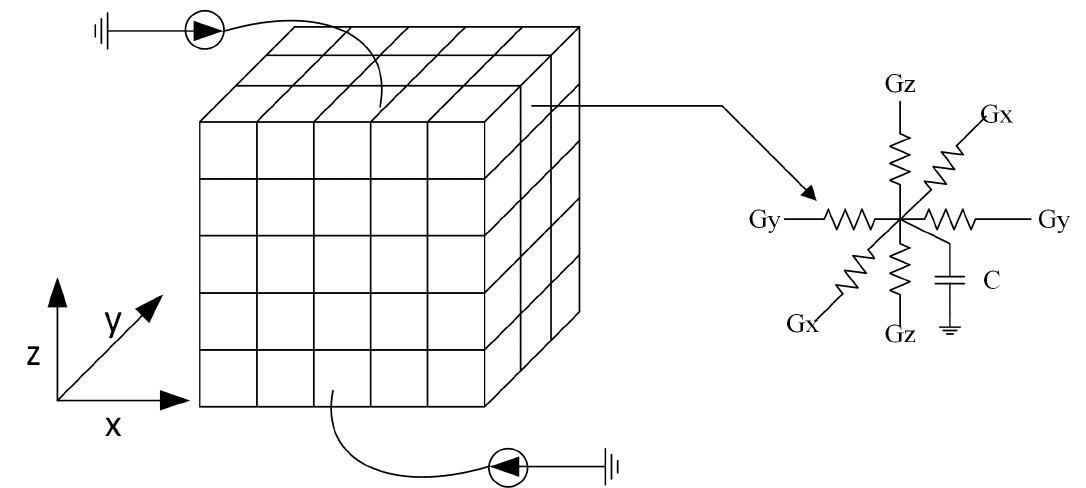
Figure 1. Spatial discretization of a chip for thermal analysis and the formulation of the electrical equivalent